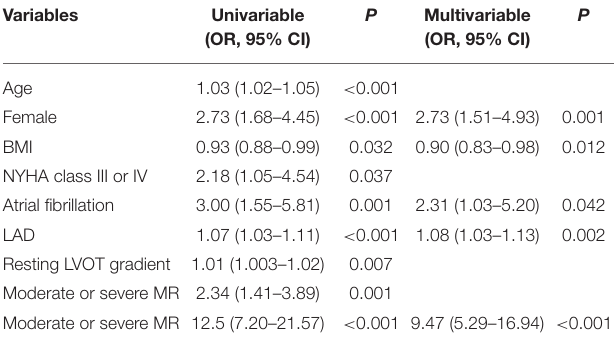
TABLE 2 | Logistic regression models for analysis of the risk factors of